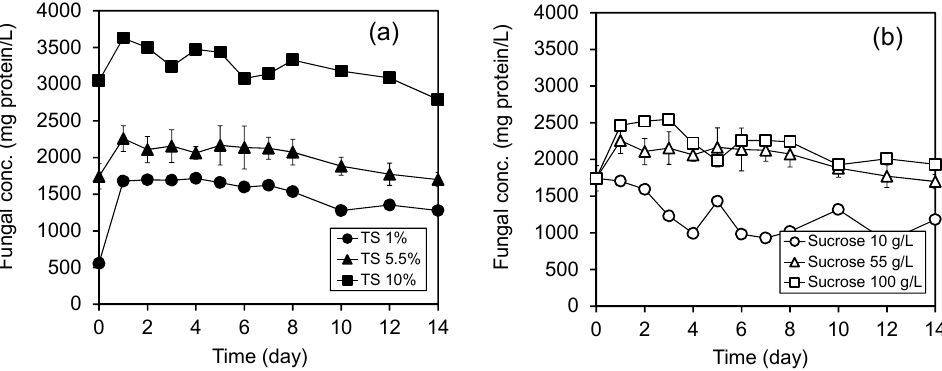
Figure 5. Variations of biomass concentration during the fungal bioleaching experiments ( a ) effects of sludge solid content, ( b ) effects of sucrose concentration.